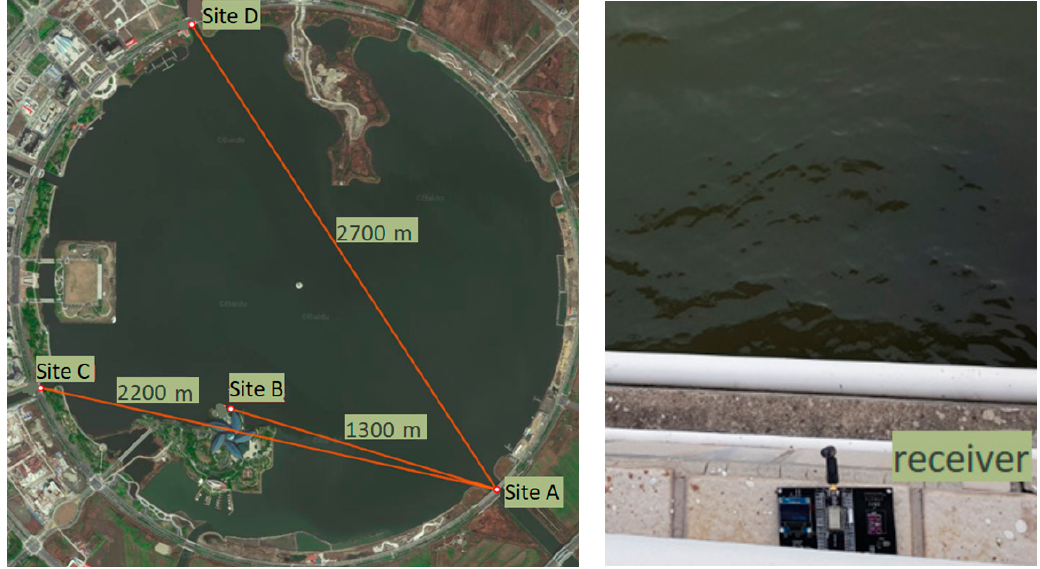
Figure 1. Map of Dishui Lake experiments and the sending and receiving nodes’ locations.